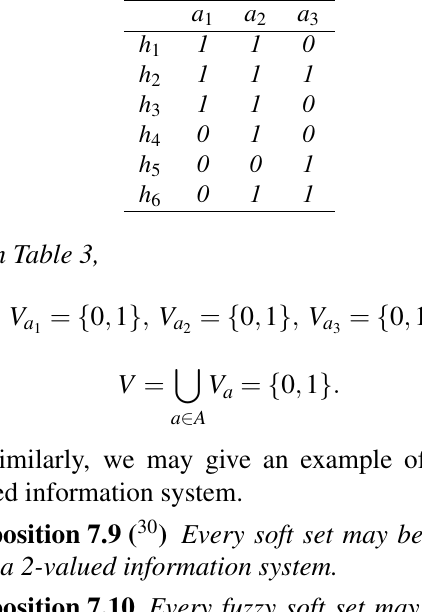
Table 3. The 2-value information system ( U , A , V , g